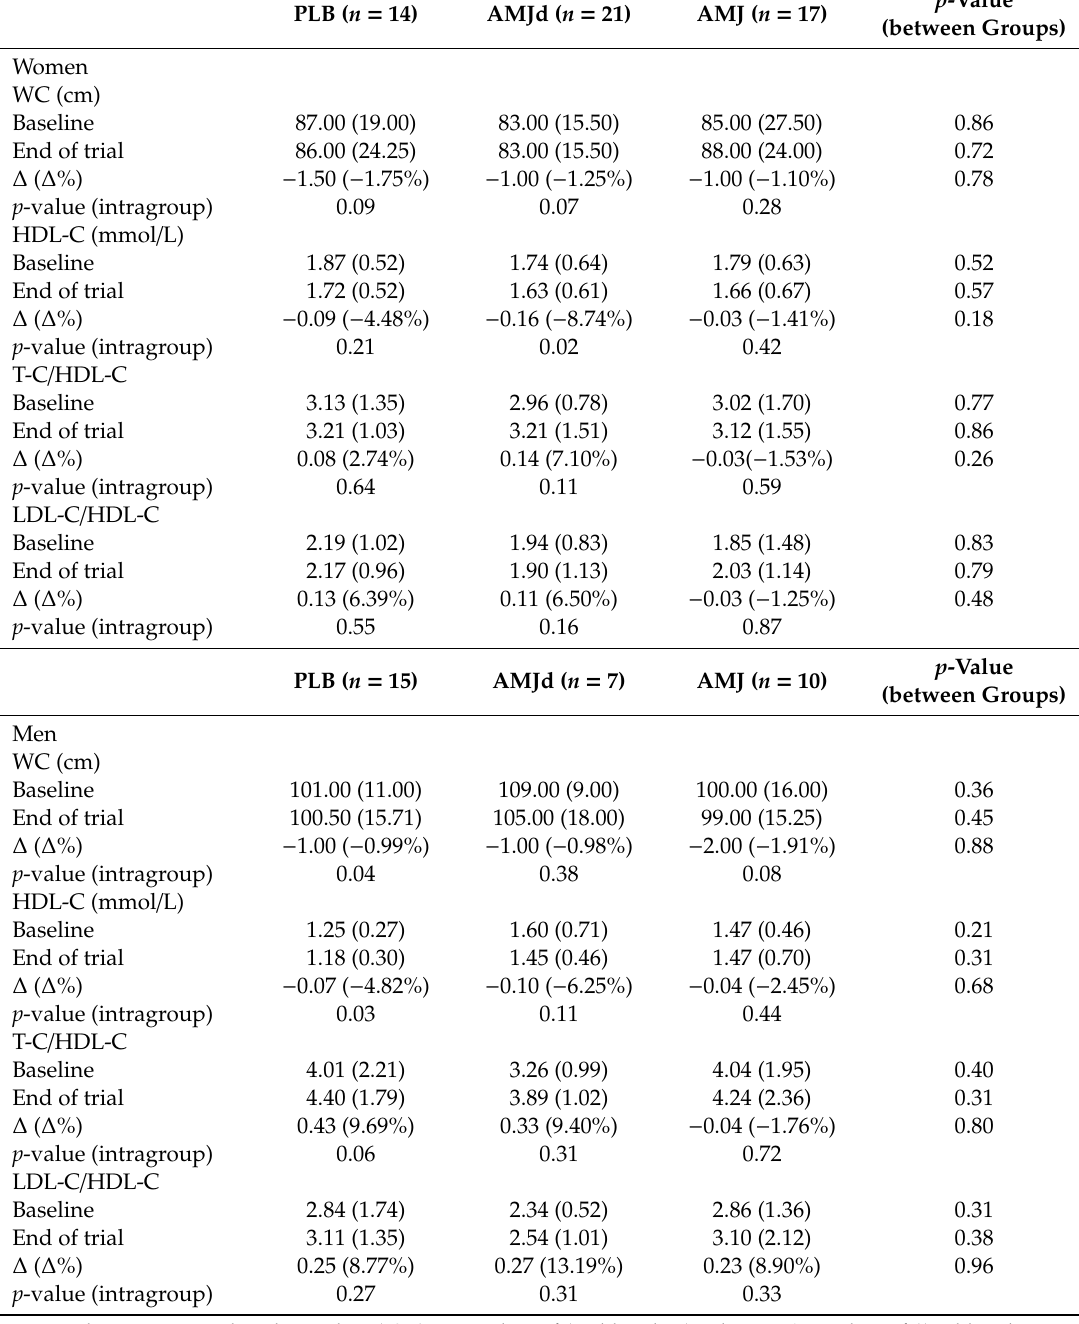
Table 2. Changes in waist circumference (WC) and HDL-cholesterol in women and men following daily intervention for four weeks with the placebo (PLB) drink, the polyphenol low-dose chokeberry juice (AMJd), and the polyphenol high-dose chokeberry juice